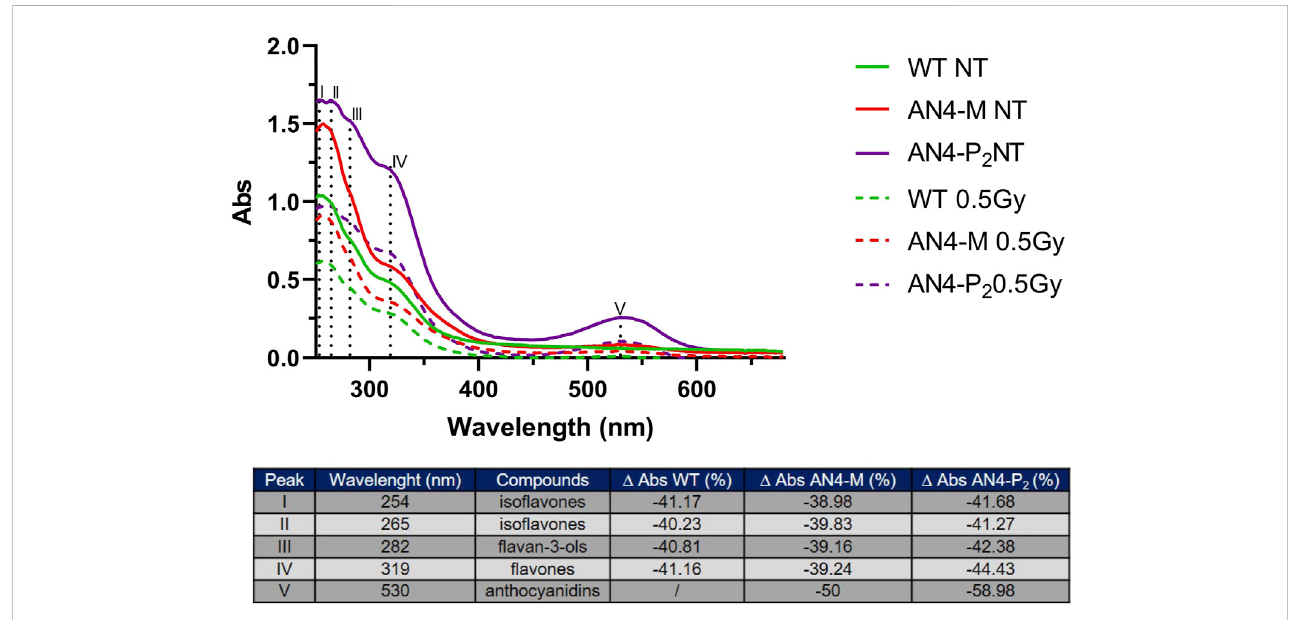
FIGURE 8 UV-VIS spectra of polyphenols extracts of ripe fruits before and after .5 kGy absorbed dose. The table reports the peaks and the corresponding compounds. The Δ Abs (%) was calculated considering the Abs after and before the irradiation for wild type, AN4-M and AN4-P 2 extracts.